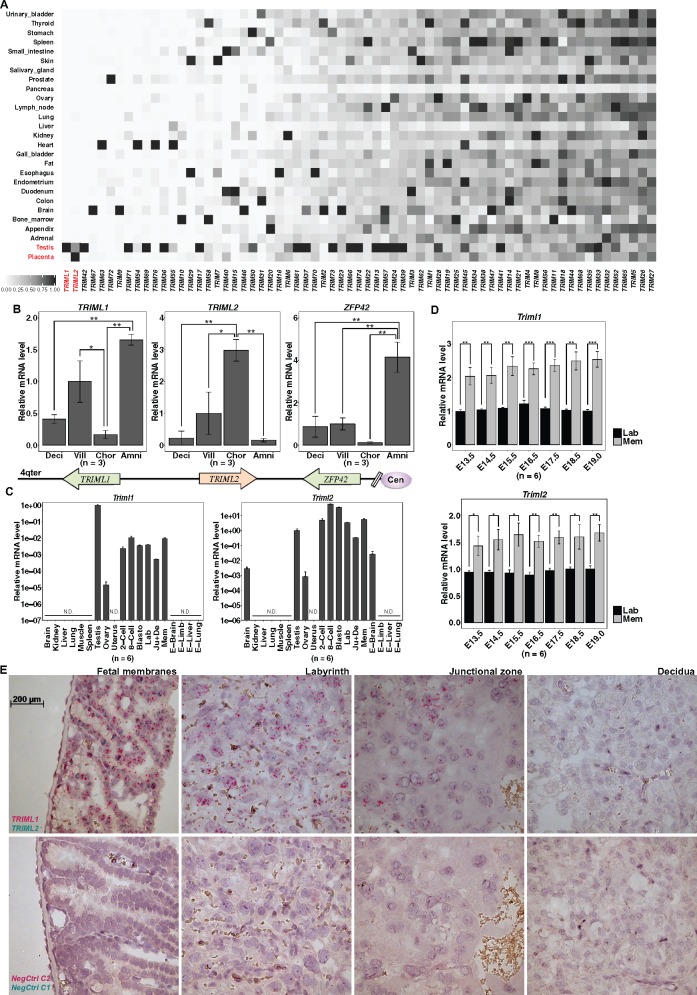

TRIML1 and TRIML2 show different restricted expression patterns. (A) Heatmap of relative tissue expression levels of human TRIM genes, showing restricted expression of TRIML1 and TRIML2 (data from the Human Protein Atlas, expression level in each tissue normalized to the highest RPKM for each TRIM gene, supplementary fig. S4, Supplementary Material online). (B) Preferential expression compartment of TRIML1, TRIML2, and ZFP42 in extraembryonic tissues correlates with their transcribing direction. Expression levels normalized to placenta villi. Values are mean ± SEM. One-way ANOVA, Tukey’s HSD, **P < 0.01, *P < 0.05. Deci, placental decidua; Vill, placental villi; Chor, chorion; Amni, amnion; Cen, centromere; 4qter, terminal of chromosome 4 long arm; arrows indicate the transcription direction of each gene. (C) Triml1 and Triml2 expression in adult and embryo mouse tissue show restricted expression in preimplantation embryo, extraembryonic tissues, testis, and ovary. Expression levels normalized to placental villi. N.D., not detected; 2-Cell, 2-cell stage embryo; 8-Cell, 8-cell stage embryo; Blasto, blastocyst; Lab, E15.5 labyrinth; Ju+De, E15.5 junctional zone, and decidua; Mem, E15.5 fetal membranes; E-Brain, E15.5 embryo brain; E-Limb, E15.5 embryo limb; E-Liver, E15.5 embryo liver; E-Lung, E15.5 embryo lung. (D) Triml1 and Triml2 show higher expression in fetal membrane than in placental labyrinth. Expression levels normalized to E19.0 labyrinth. Values are mean ± SEM. t-Test, ***P < 0.001, **P < 0.01, *P < 0.05. (E) RNAScope assay showing Triml1 and Triml2 expression in extraembryonic structures, upper row: signal from Triml1 and Triml2-specific probes, lower row: nonspecific signals from negative control probes.